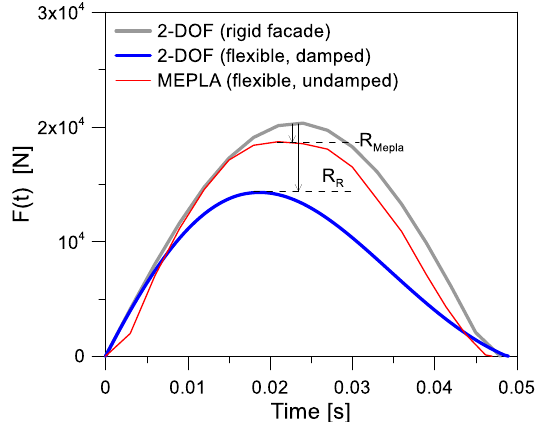
Figure 4. Qualitative comparison of input impact forces for a given glass facade, as obtained under ideal conditions (rigid facade), from MEPLA (flexible, undamped facade) or by accounting for the proposed approach (impactor/facade properties and damping).